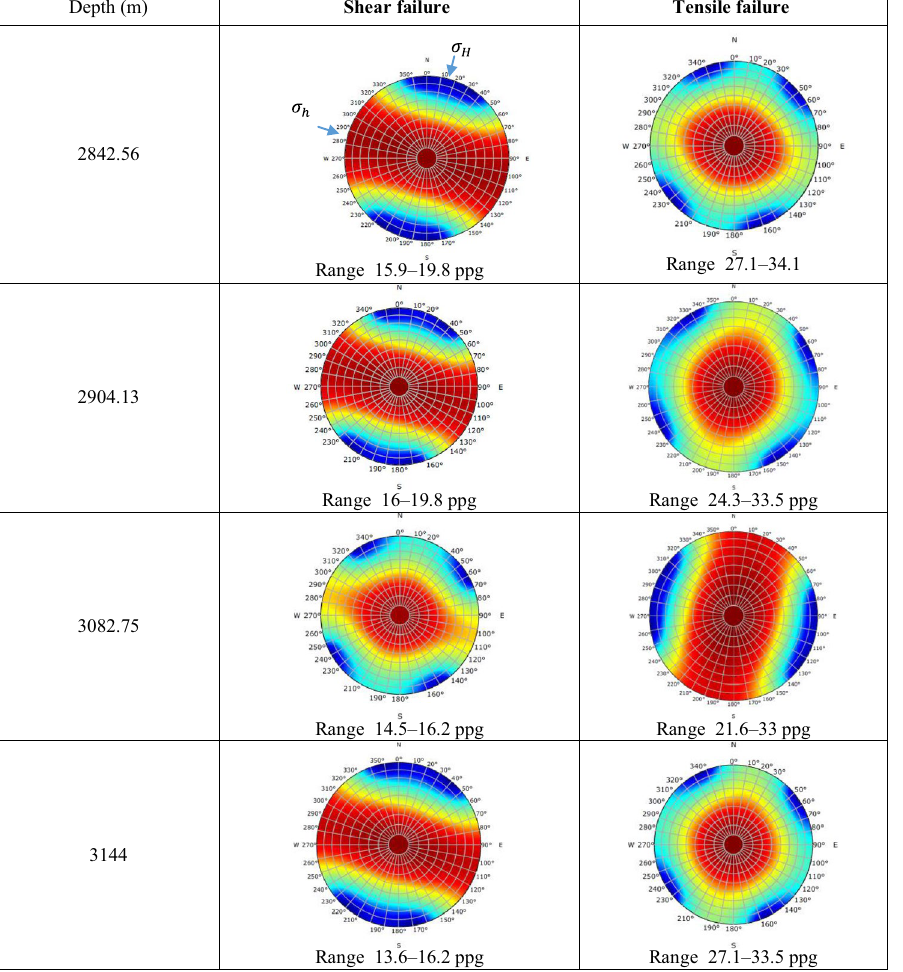
weights for shear and tensile failures at four selected depths (using Mogi–Coulomb failure